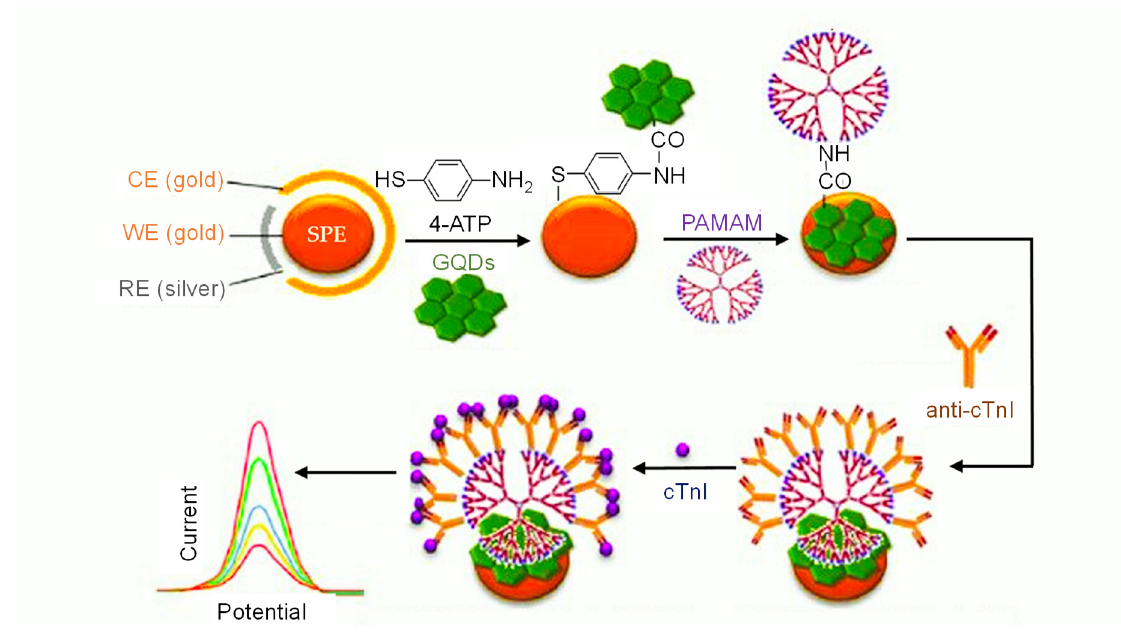
Figure 20. Schematic presentation of a voltammetric antibody sensor for cTnI [79].